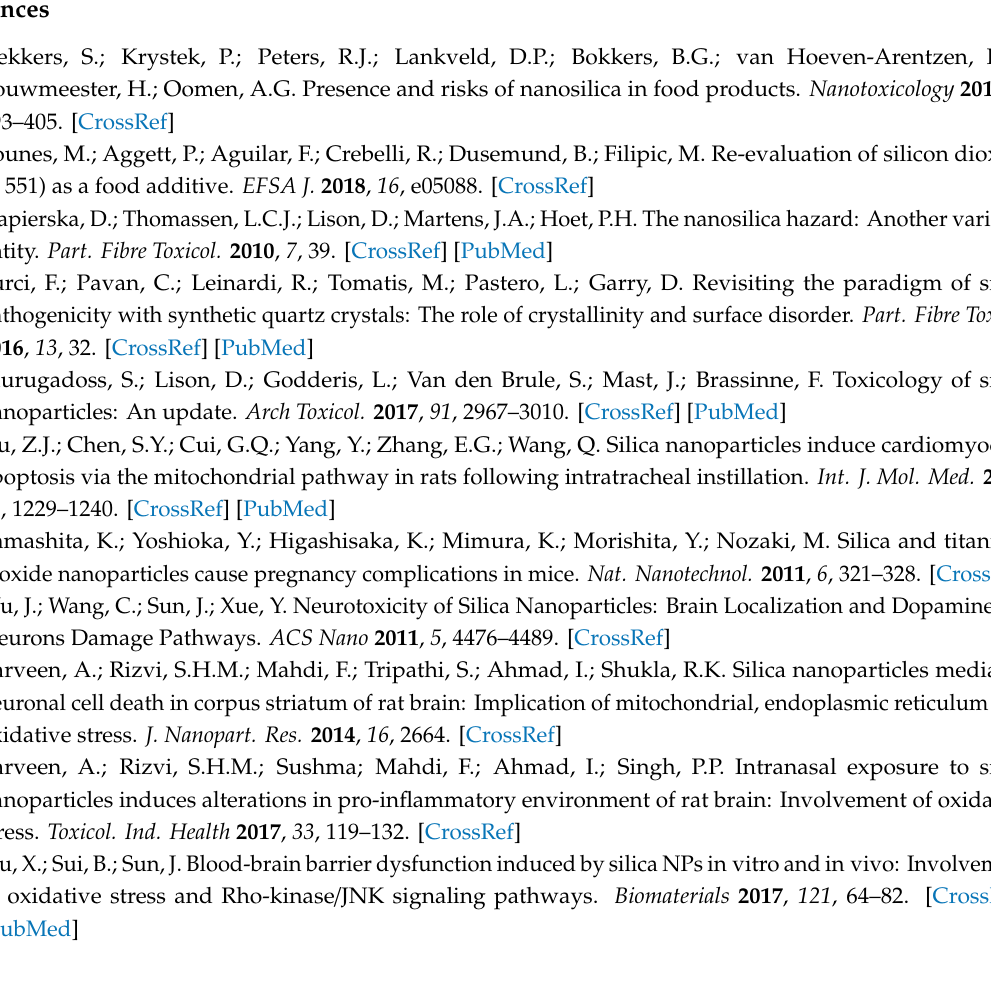
Table S1: Spectral bands (cm − 1 ) of chemical bonds of biomolecules detected by ATR-FTIR Spectroscopy in rat astrocytes and neurons exposed to SiO 2 -NPs; Figure S1. Identification of cell cultures; Figure S2. A spectral fingerprint of rat astrocytes and neurons exposed to SiO 2 -NPs; Figure S3. FTIR microscopy and IQ mapping analysis of the spectral region of 989–1185 cm − 1 of astrocytes exposed to SiO 2 -NPs; Figure S4. FTIR microscopy and IQ mapping analysis of the spectral region of 989–1185 cm − 1 of astrocytes exposed to SiO 2 -NPs. FTIR microscopy analysis and IQ mapping of neurons exposed to SiO 2